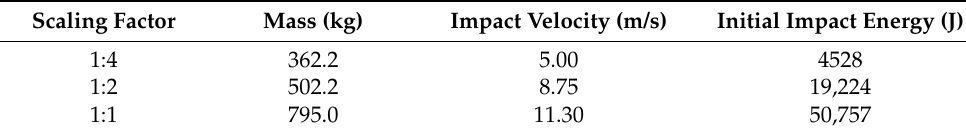
Table 2. Impact velocity and energy in impact